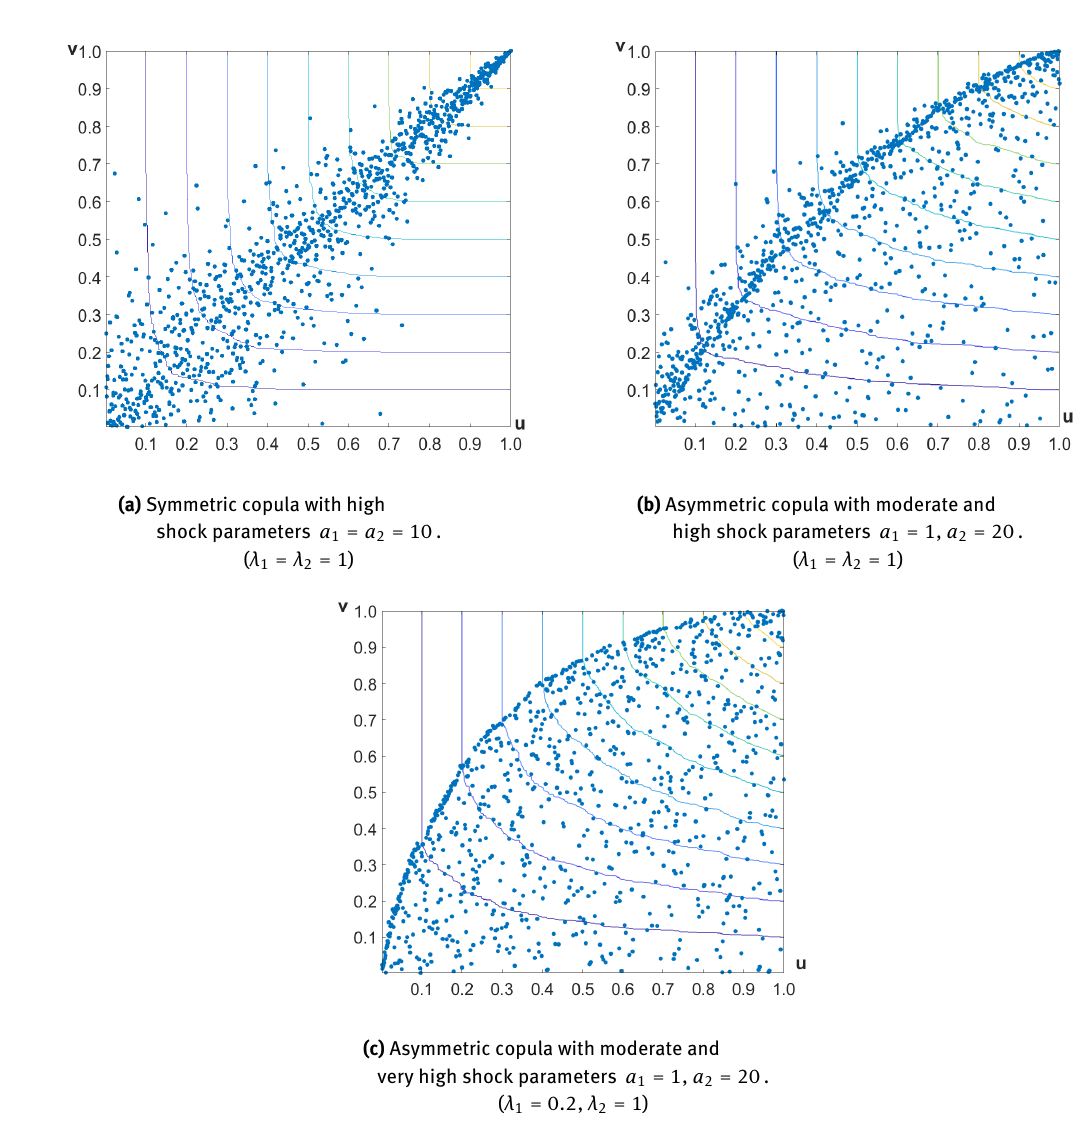
Figure 3: Scatter plots of copulas for different parameter settings based on samples of size 1000 . The contour lines of the empirical copula functions for the values 0.1, . . . , 0.9 are also